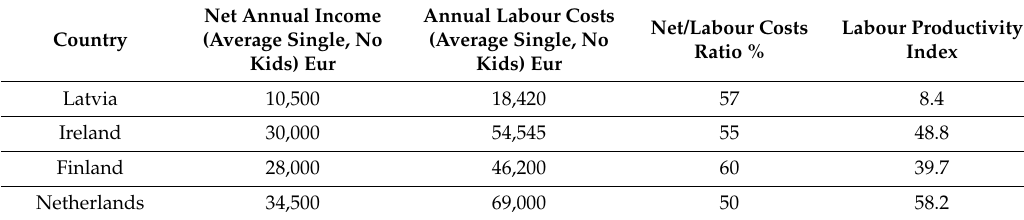
Table 2. Labour costs 2015 year (based on Eurostat [10], Deloitte [11], Central Statistical Bureau of Latvia [12]).